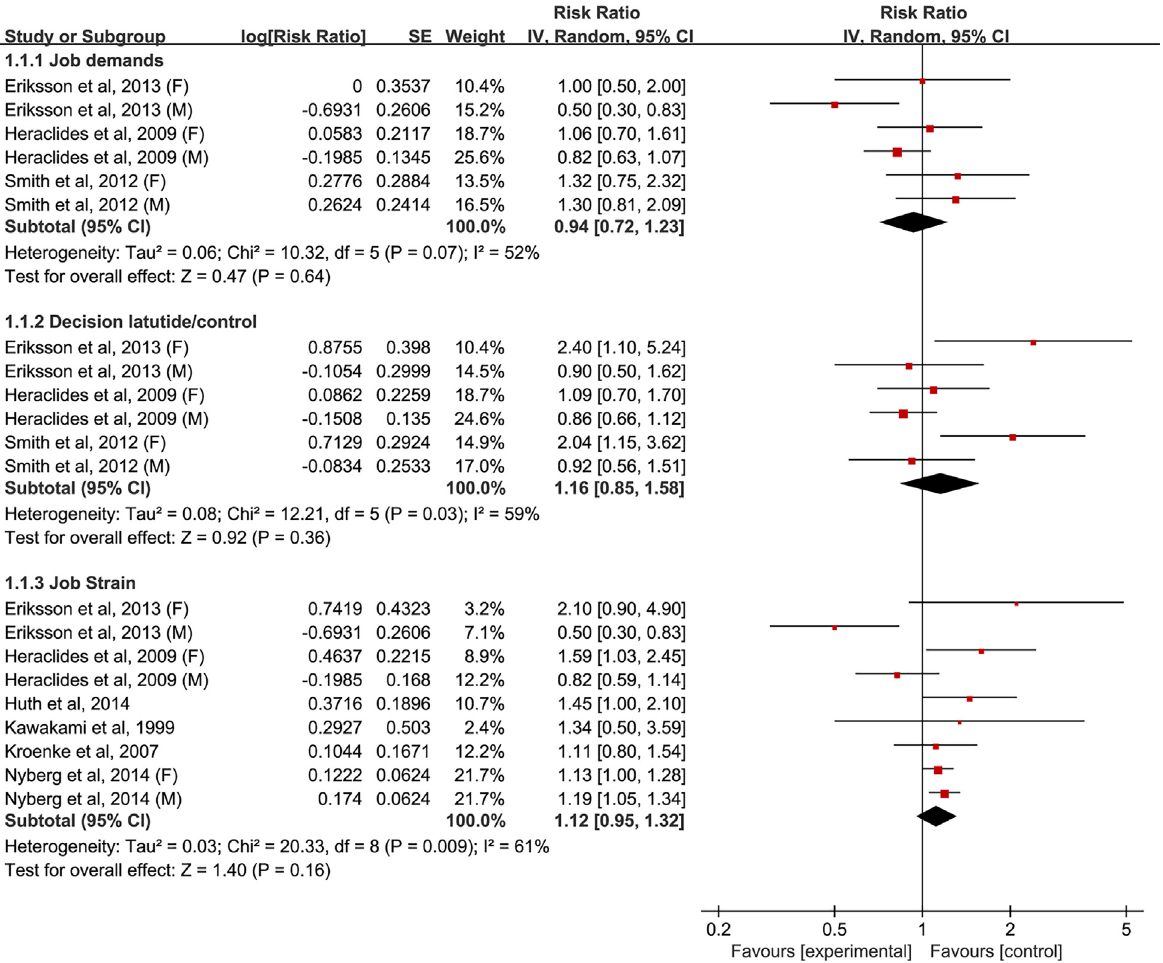
Fig 2. Forest plot of the association between the job strain model and type 2 diabetes risk. SE, standard error; CI, confidence interval; M, male; F, female.